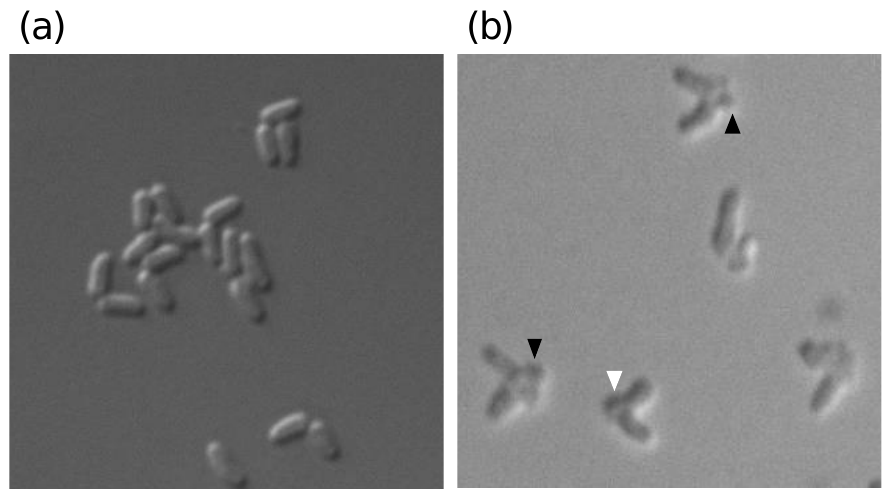
Figure 4. Bulge formation at cell division sites in the ltsA mutant upon lysozyme treatment. Differential interference contrast (DIC) microscopic images of the wild-type strain KY9611 ( a ) and its ltsA mutant strain KY9714 ( b ) are shown. Black arrow heads represent the cells with two bulges and the white arrowhead refers to a cell with one bulge. A bar represents 2 m.